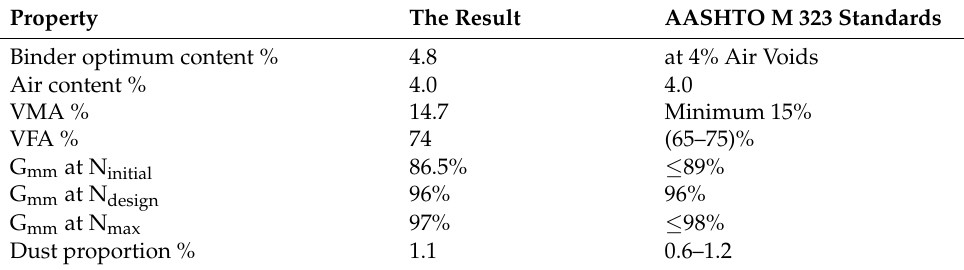
Table 17. The volumetric properties of the HMA mixture at optimum binder content.